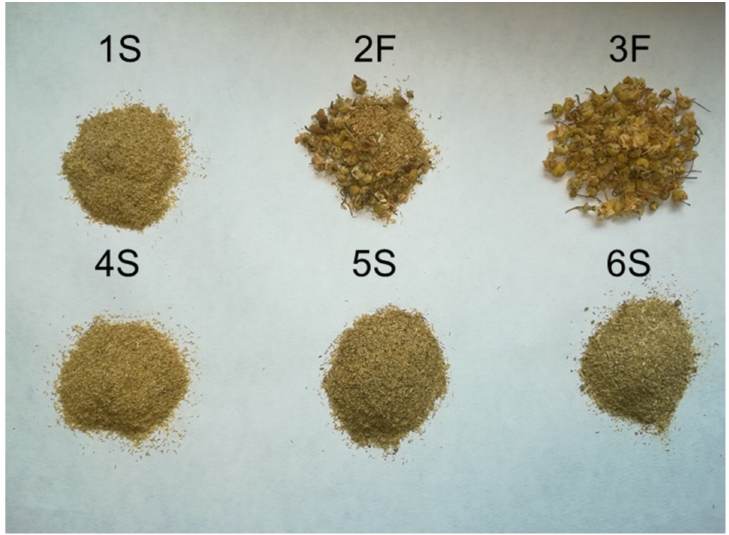
Figure 1. Image of the six different brands of chamomile samples used in the study.